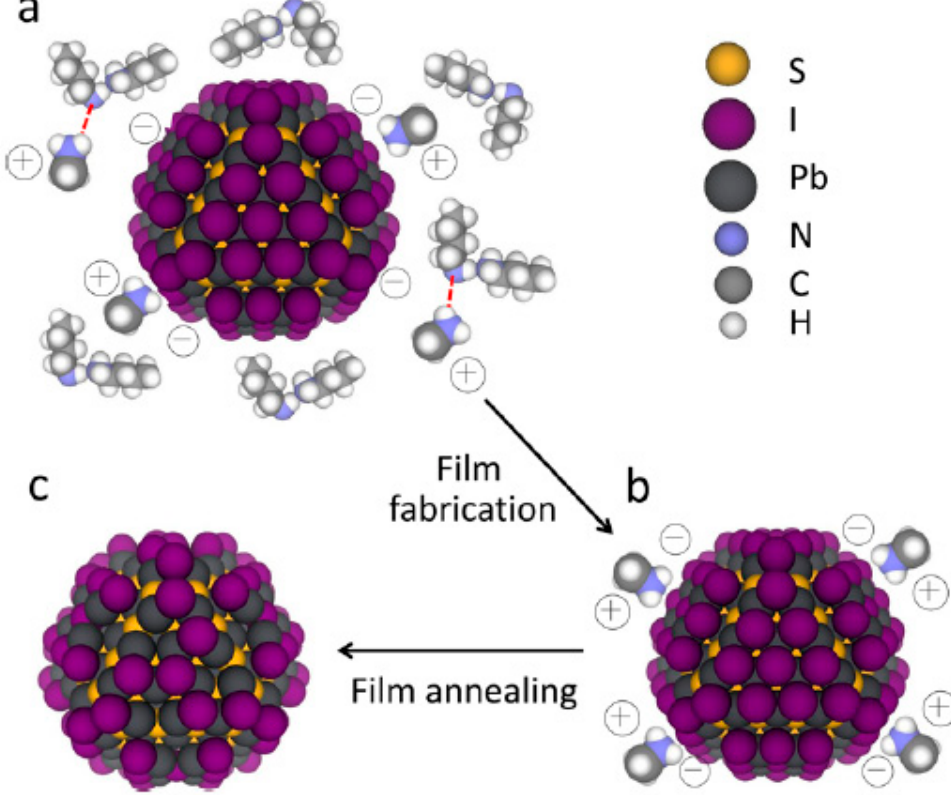
Figure 6. Schematic of surface ion distribution of PbS CQDs. ( a ) The PbS CQDs prepared after ligand exchange with iodide in butylamine. Iodide anions attached on the PbS CQD surface are surrounded by methylammonium counter cations. Methylammonium can be removed from the surface by reaction with butylamine. ( b ) As-deposited PbS CQD films. The counter ions residing on the CQD surface to keep neutrality of charge. ( c ) Annealed PbS CQD film. The ion pairs are removed, but most of the iodide ligands remain on the CQD surface. Reprinted from reference [34]. Copyright 2014 American Chemical Society.